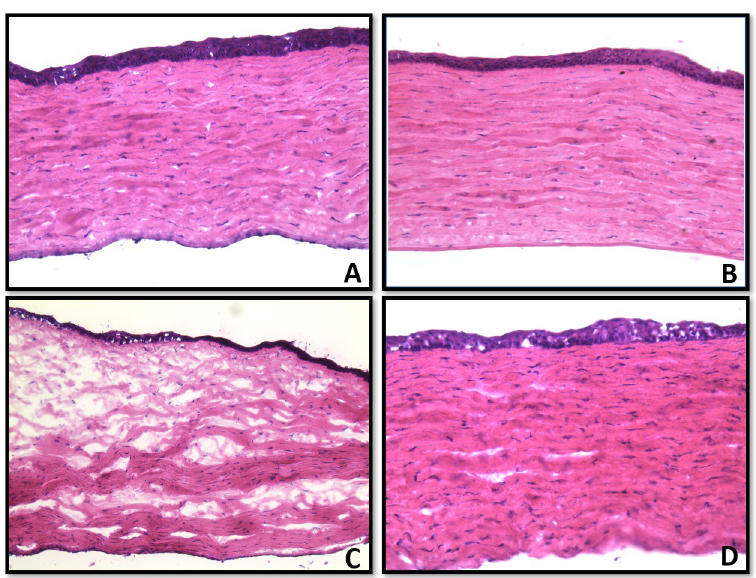
Fig 4. Representative H&E stained corneal tissue sections showing toxicity and efficacy in vivo . Corneal sections of naive Group-2 (A), unwounded eyedrop-treated Group-4 (B), alkali wounded Group-1 (C), and alkali wounded and eyedrop-treated Group-4 (D) eyes. Group-2 (A) and Group-4 corneas showed normal corneal morphology. Alkali injury led to significant stromal edema and disorganized collagen, as well as a thin keratinized epithelial layer (C) and eyedrop treatment markedly improved corneal pathology through better collagen fibrils organization, less stromal edema, and re-epithelialization with a full-thickness epithelium (D). Magnification 20x. treatment was well tolerated in unwounded control eyes with no evidence of deleterious clini- cal side effects based on mMs scoring, CCT, and IOP. Twice daily dosing was used in this study to good effect but it is possible that treatment intervals in higher mammals (dogs, cats, horses, people) may require more frequent application due to differences in tear film and blink rates.